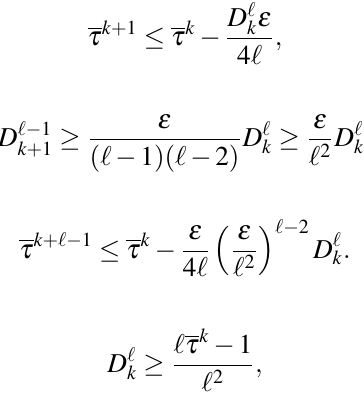
Figure 7: Intersection of cubes in the case where the rate is bigger than 1 / 3. The thickening of the cubes of W k + (cid:101) Λ k is represented in dark blue and the thickening of the rest of the cubes of W k + 1 + (cid:101) Λ k + represented in light blue; we have also represented another cube of W k + 2 + (cid:101) Λ k + the projection on the z -axis of the centre of the yellow cube is smaller than 1, then there is automatically an intersection between this cube and one of the blue